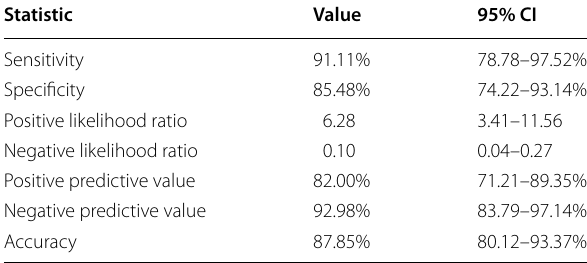
Table 7 Showing the accuracy measures in method